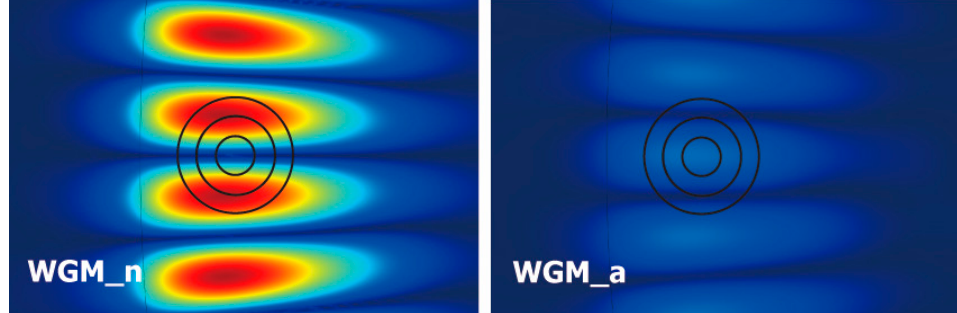
Figure 5. (Color online) Electric field distributions at the position of the nanocylinder for the two split WGMs. The circle indicate nanocylinders with ((cid:1844) (cid:3030) = 50, 75, and 100 nm) , respectively.